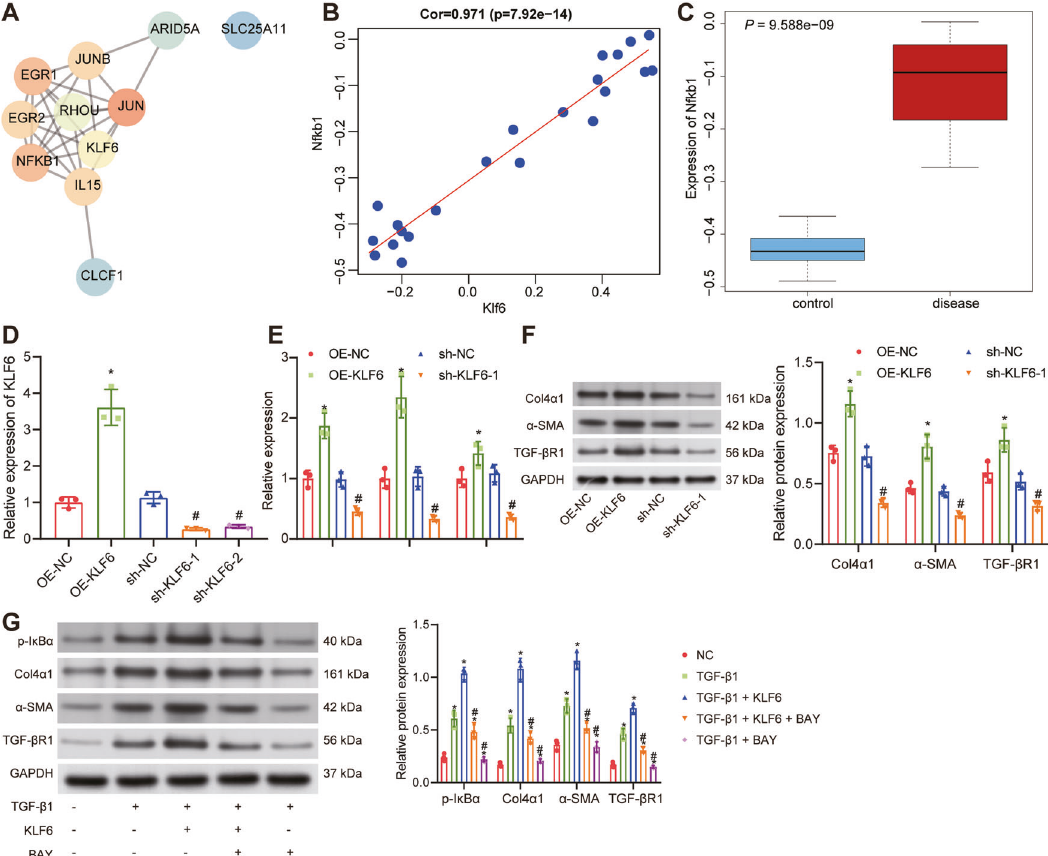
Fig. 5 KLF6 promotes fi brosis of HK-2 cells by activating the NF- κ B signaling pathway. A PPI network of KLF6 and its top ten related genes constructed using the String website. The redder the color of the gene, the higher the degree of correlation; the bluer the color of the gene, the lower the degree of correlation. B A diagram of the correlation between KLF6 and NFKB1 expression. C A box line diagram of NFKB1 expression data from the GSE36496 dataset. The blue box on the left represents the expression in normal control samples and the red box on the right represents the expression in renal fi brosis samples. D The transduction ef fi ciency of oe-KLF6 and sh-KLF6 as veri fi ed by RT-qPCR in HK-2 cells. * p < 0.05 vs . oe-NC. # p < 0.05 vs . sh-NC. E The effect of KLF6 on the mRNA expression of α -SMA, Col4 α 1, and TGF- β in HK-2 cells as detected by RT-qPCR. * p < 0.05 vs . oe-NC. # p < 0.05 vs . sh-NC. F Western blot analysis of α -SMA, Col4 α 1 and TGF- β protein expression in HK-2 cells with KLF6 overexpression or knockdown. * p < 0.05 vs . oe-NC. # p < 0.05 vs . sh-NC. G Western blot analysis of I κ B α phosphorylation and α